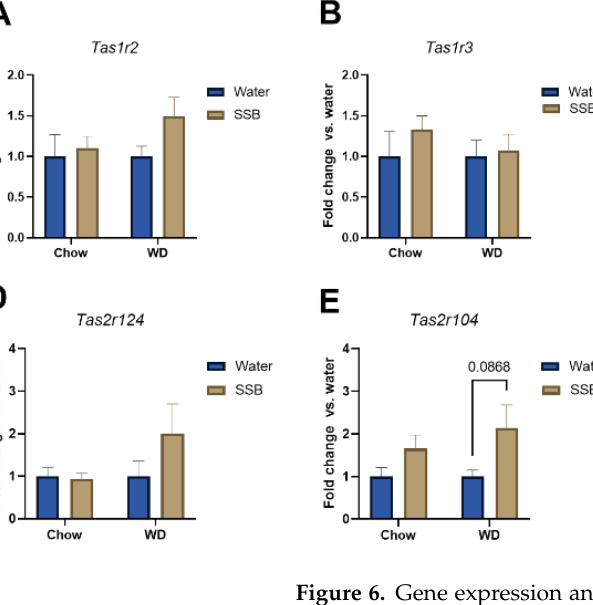
Figure 6. Gene expression analysis with qPCR of ( A ) Tas1r2 , ( B ) Tas1r3 , and ( C ) Slc2a1 , encoding for the glucose transporter one, ( D ) Tas2r124 , ( E ) Tas2r104 , ( F ) Tas2r106 , and ( G ) Tas2r130 . RNA was obtained from the CV of mice that received either a standard diet (chow) or Western-type diet (WD) with water (Water, blue bars) or a sugar-sweetened beverage (SSB, brown bars) as a drink for 24 weeks. Mean fold changes ± SEM in gene expression of the SSB-fed diet groups is displayed in rela- tion to the respective water- fed group (=1). Statistical significance was tested using Student’s t -test or Mann – Whitney U test in case of Tas2r106 and Tas2r130 and assumed at p < 0.05 and is marked by *, n = 9 – 10 for chow group, n = 7 – 8 for the WD group .